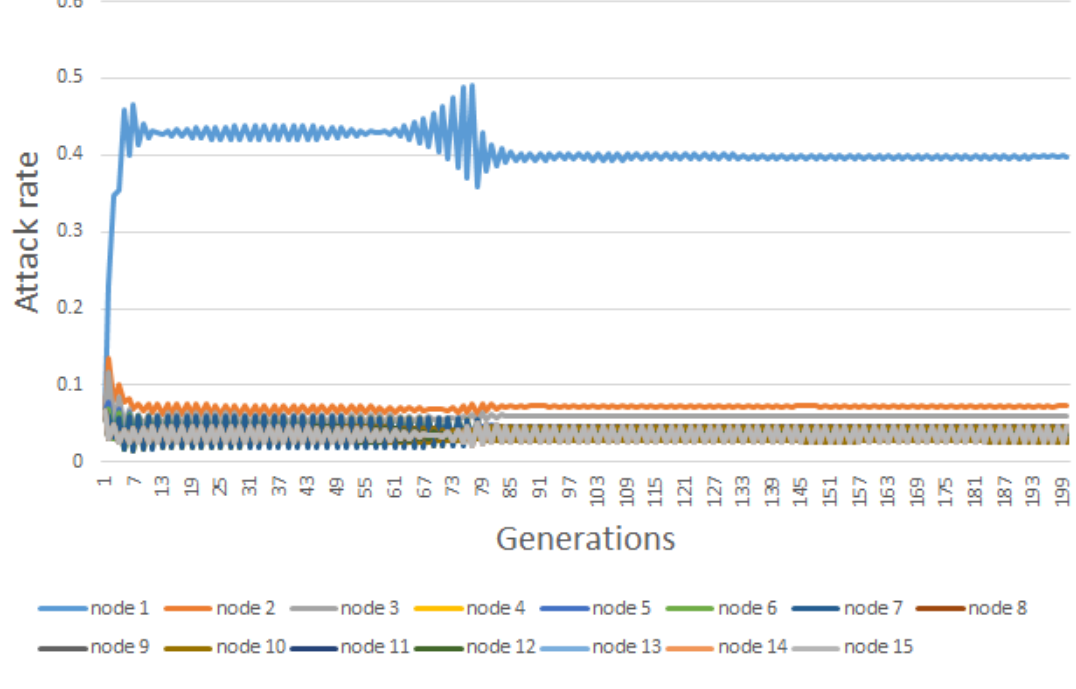
Figure 4. Evolution graphs for average attack rate showing the results for the nodes of the case study. The defender’s budget is equals to 1.0. The x-axis presents the generations. The y-axis presents the evolution of average rates.